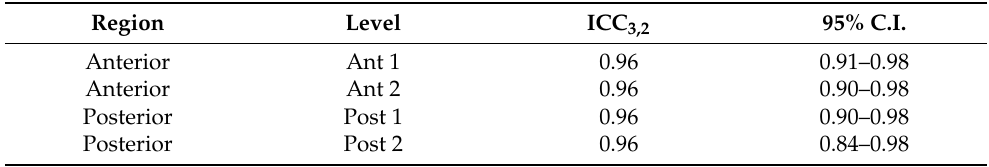
Table 6. Intra-rater reliability of the ultrasound measurements within different regions/levels of the superficial fascia of the arm between two sessions by